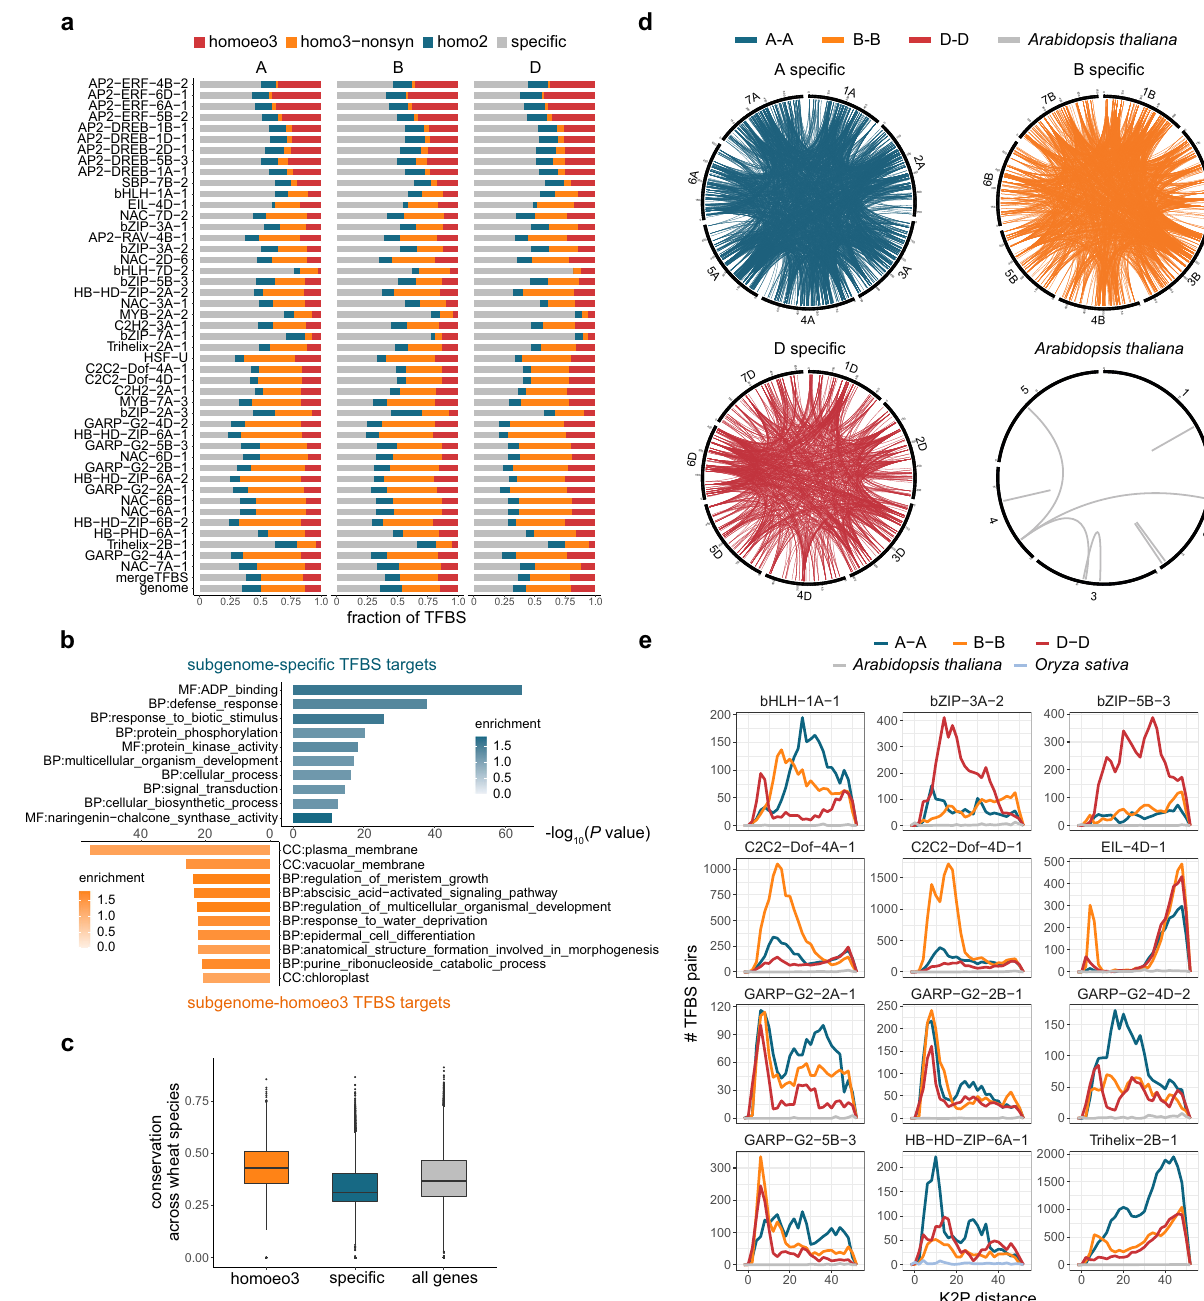
Fig. 3 | Common wheat TFBSs underwent one or more round(s) of expansion. a Fraction of TFBSs in subgenome-homologous regions as determined by the reciprocal alignment across subgenomes. Homoeologou regions syntenic across three subgenomes were de fi ned as homoeo3. b Most enriched GO terms for the subgenome-homoeologous and -speci fi c TFBS-biased targeted genes ranked according to the enrichment P value determined by two-tailed Fisher ’ s exact test. The upper and lower bars represent high enrichment for subgenome-speci fi c and -homoeologous TFBS targets, respectively. c Box plot showing the distribution of the conservation scores for subgenome-homoeologous ( n =8140) and -speci fi c ( n =14,540) TFBS target genes and all genes (genes in the chrUn were removed, n =105,200)acrossfourwheatspecieswithdifferentploidylevels.Horizontallines in boxplots show median, hinges show interquartile range (IQR), whiskers show